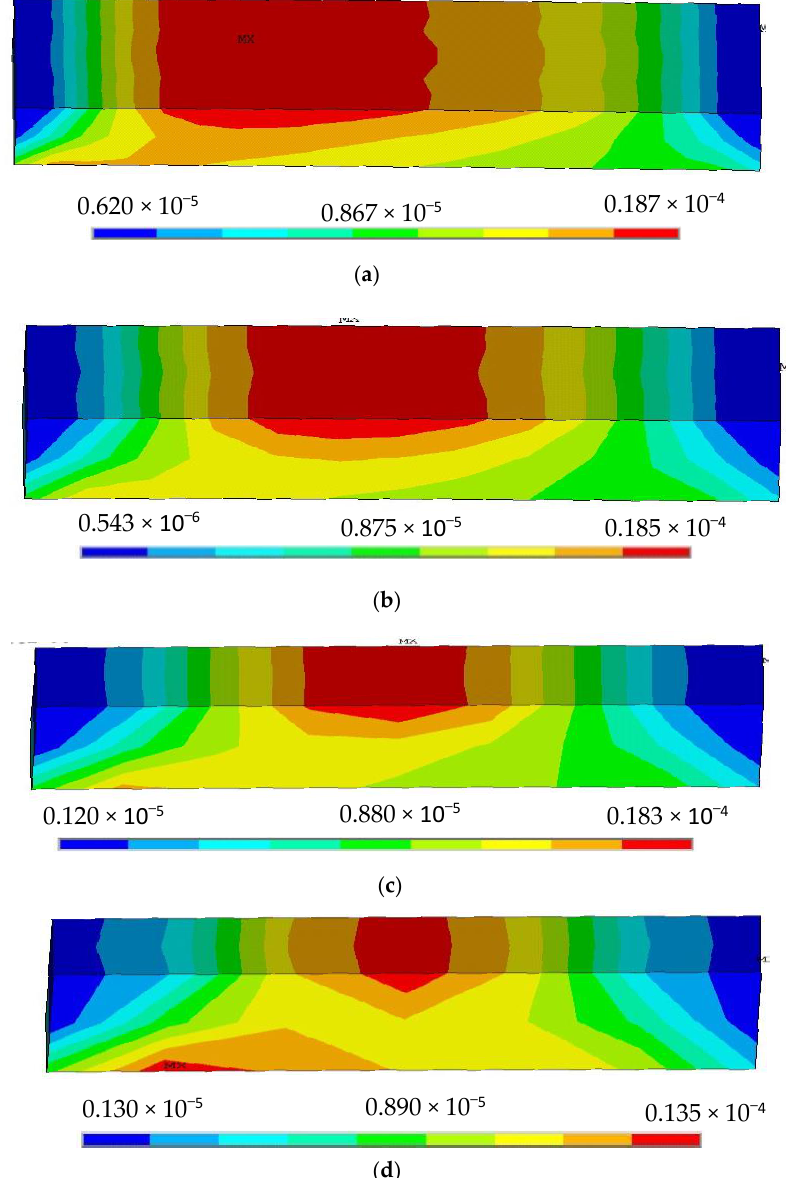
Figure 5. Stress distribution nephogram of silica gel with different thickness: ( a ) H = 2 mm, ( b ) H = 5 mm, ( c ) H = 8 mm, ( d ) H = 10 mm.